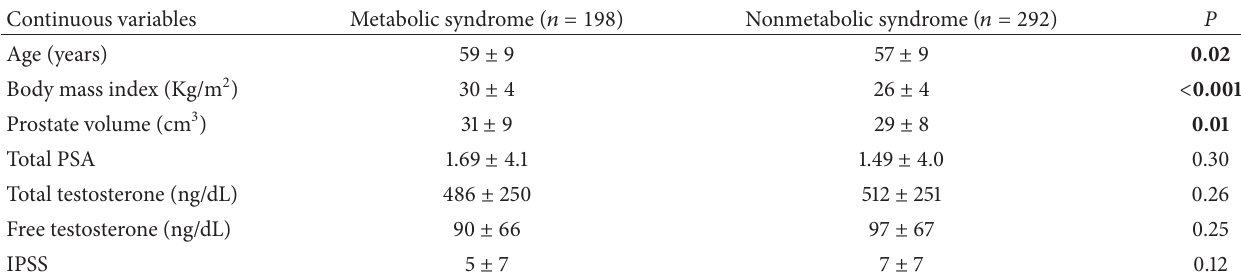
Table 1: Demographic parameters of patients according to the presence of metabolic